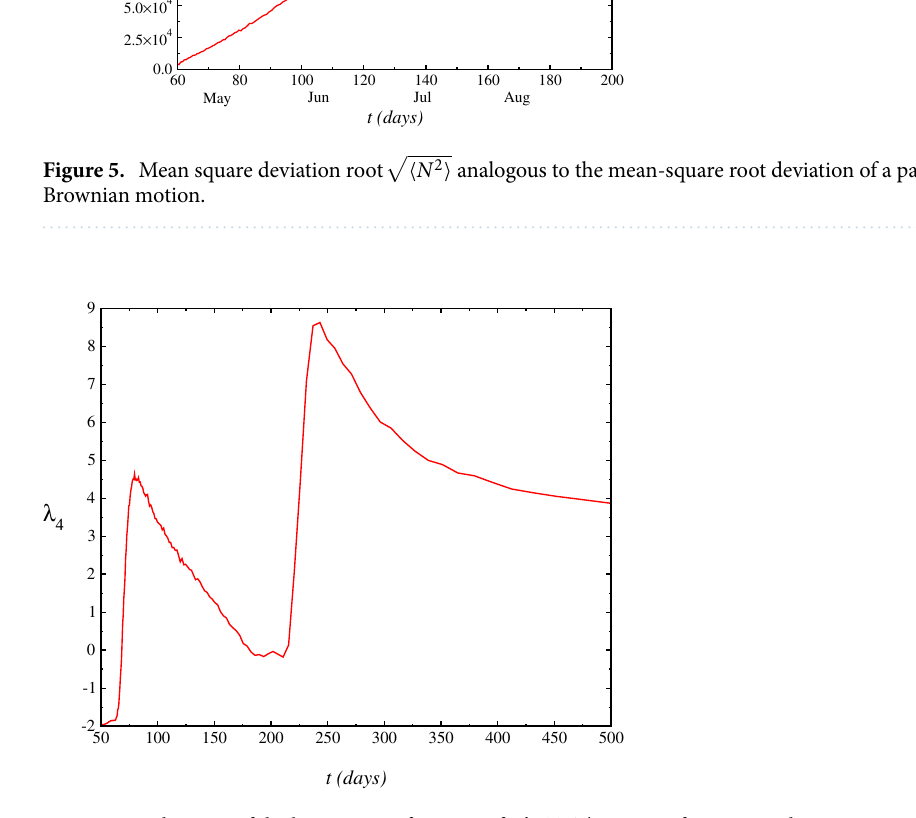
Figure 6. Behaviour of the kurtosis as a function of t (cid:31) 4 ( t ) . The range of negative values gives an estimating of 0 at range of large t values since the firsts the shape of distribution which becomes nearest of a Gaussian for (cid:31) 4 = th cases reported in the Brazil on 15 March